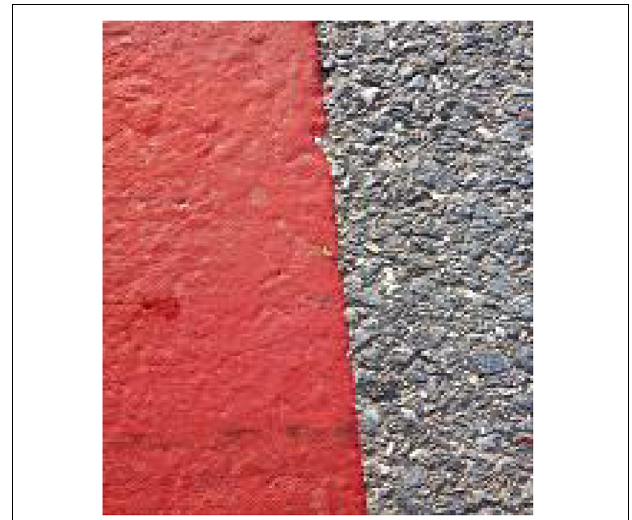
FIGURE 6 | CEASM after using for 6 months.